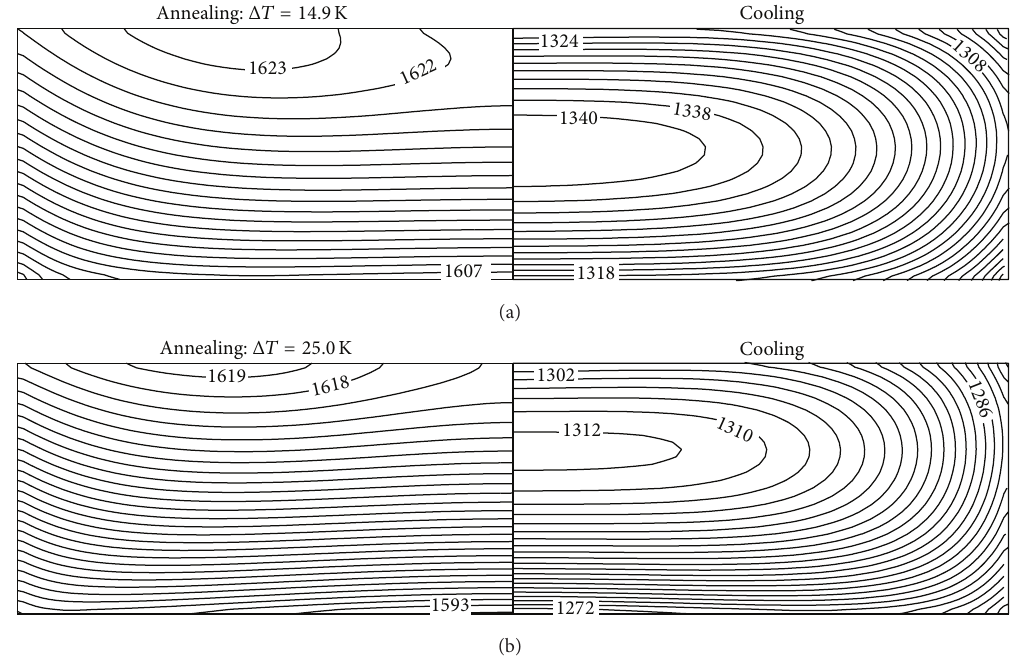
Figure 7: Temperature distribution in the silicon ingots at the end of annealing (left, 1K between isotherms) and during cooling (right, 2 K between isotherms) for DS processes with different crucible thermal conductivities: (a) 2 W/m ⋅ K; (b) 6 W/m ⋅